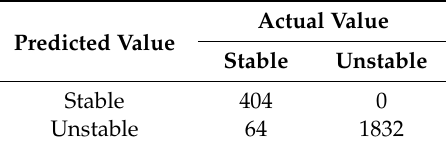
Table 5. Stability prediction results after optimization (first 100 cycles).